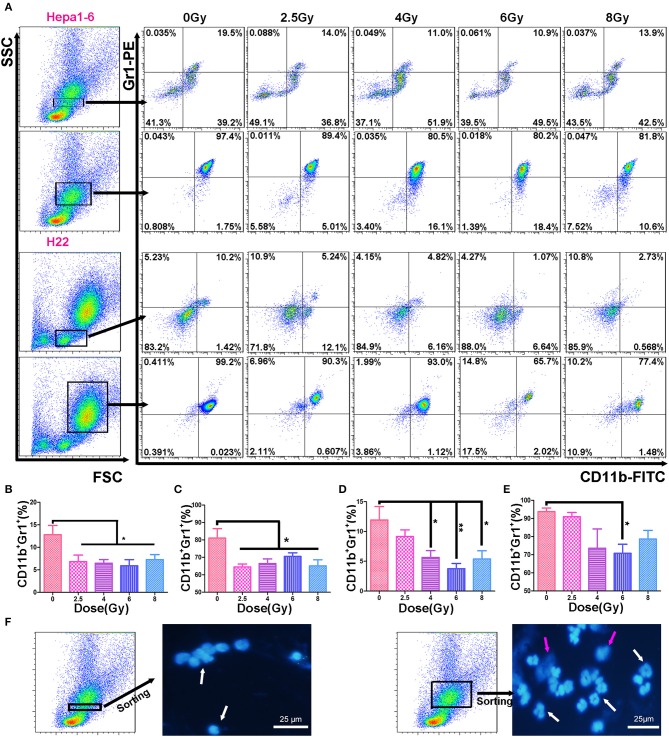
Hypofraction irradiation (IR) reduced the percentage of myeloid-derived suppressor cells (MDSCs) in peripheral blood. On day 3 after a 40-Gy total IR, MDSCs (CD11b+Gr1+) in mouse peripheral blood were measured with flow cytometry (FCM) in both Hepa1-6/C57BL/6 and H22/Institute of Cancer Research (ICR) mouse models (A). The percentages of MDSCs within monocyte population (the first and third rows of FCM charts, A) and granulocyte population (the second and fourth rows) in Hepa1-6/C57BL/6 (the first and second rows) and H22/ICR (the third and fourth rows) mouse models were compared among the groups with different doses of fractional IR. There were significant differences in monocyte-like MDSCs (B,D) and granulocyte-like MDSCs (C,E) between irradiated groups and unirradiated control group in both animal models [(B, C) from Hepa1-6/C57BL/6; (D, E) from H22/ICR mouse model] (*p < 0.05 and **p < 0.01). The nuclear morphological differences between the monocyte-gated MDSCs and granulocyte-gated MDSCs were sorted by flow cytometry and observed after DAPI staining. Images were acquired using a fluorescence microscope (Olympus, Japan). Magnification 400× white ↑ for target nuclear and red ↑ for impurities in the background (F).